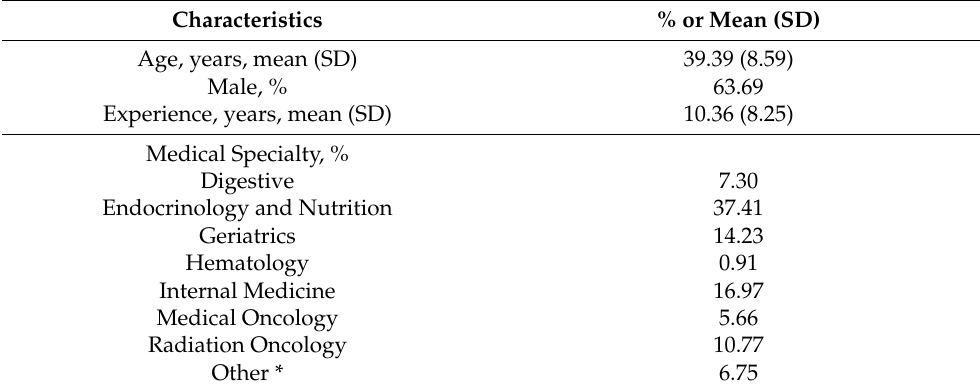
Table 1. Physicians’ sociodemographic and clinical characteristics (n =